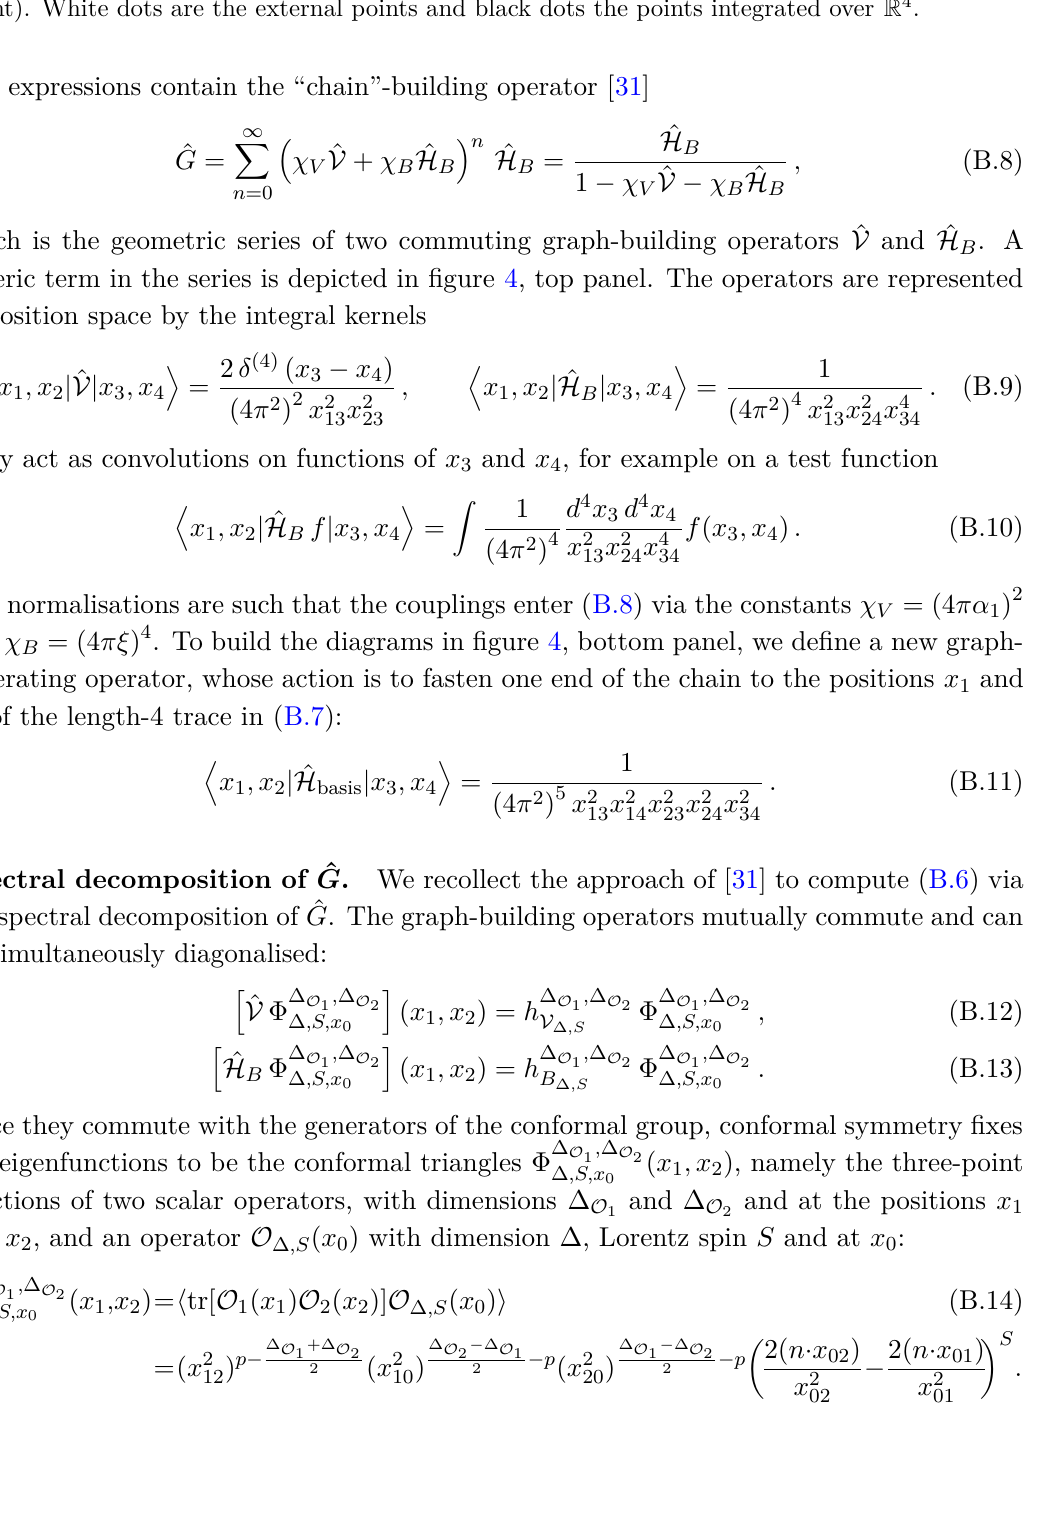
Figure 5 . The kernels associated to the graph-building operators ˆ V (left), ˆ H B (center) and ˆ H basis (right). White dots are the external points and black dots the points integrated over R 4